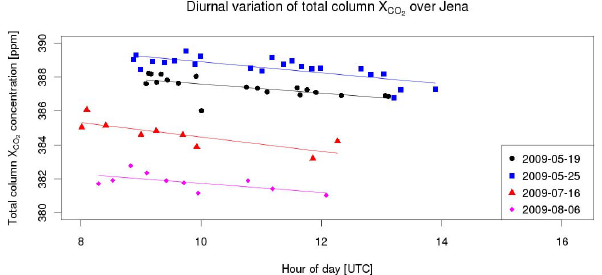
over Jena shown 2 over the day was relatively 2